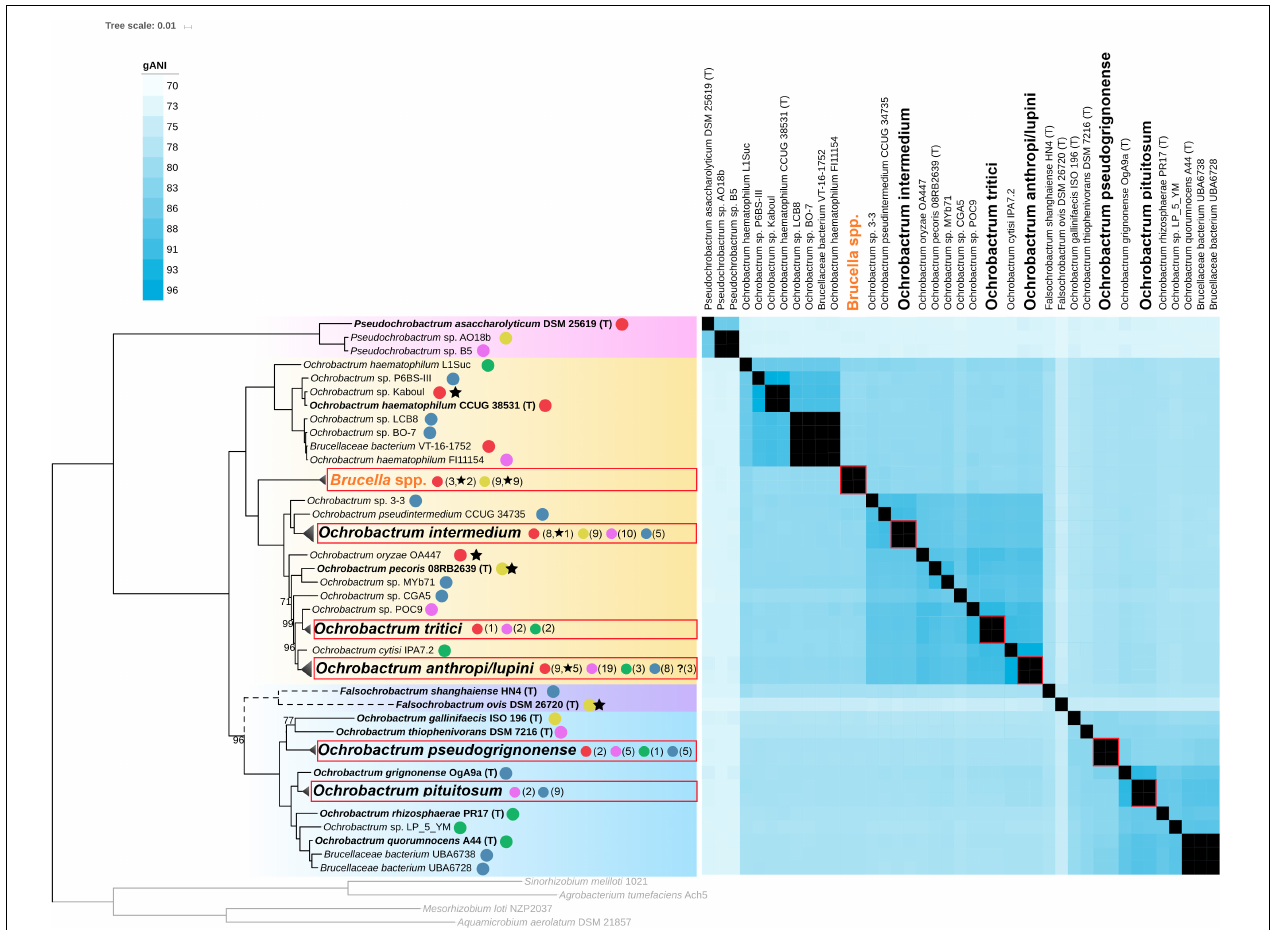
FIGURE 2 | ML Phylogenetic tree of the Brucellaceae clade. The tree was computed using RaxML from an alignment of 195 core proteins, and rooted using four members of the Rhizobiaceae and Phyllobacteriaceae families (depicted in gray). Branching support was estimated using 100 bootstrap replicates, with only values lower than 100% displayed. Genomes of type strains are in bold font. The Pseudochrobactrum clade is indicated with pink background, the Falsochrobactrum in purple background, and the Ochrobactrum Clades 1 and 2 are indicated with orange and blue backgrounds, respectively. Monophyletic clades corresponding to genomic species and including 5 genomes or more are collapsed and boxed in red. Branching of Falsochrobactrum spp. is depicted in dashed lines to reflect conflicting topology with the phylogeny displayed in Figure 1 . Origin of strain isolation is indicated with a colored dot: red, human; yellow, animal; pink, anthropized environment; green, plant rhizosphere; blue, other (environmental). Numbers in parenthesis indicate the number of genomes of each origin for collapsed clades. Stars indicate human or animal clinical isolates. The heatmap represent pairwise genome gANI values from 70 (light blue) to 96.5 (deep blue). Values larger than 96.5 (the genomic species threshold) are displayed in black. Collapsed gANI values are boxed in